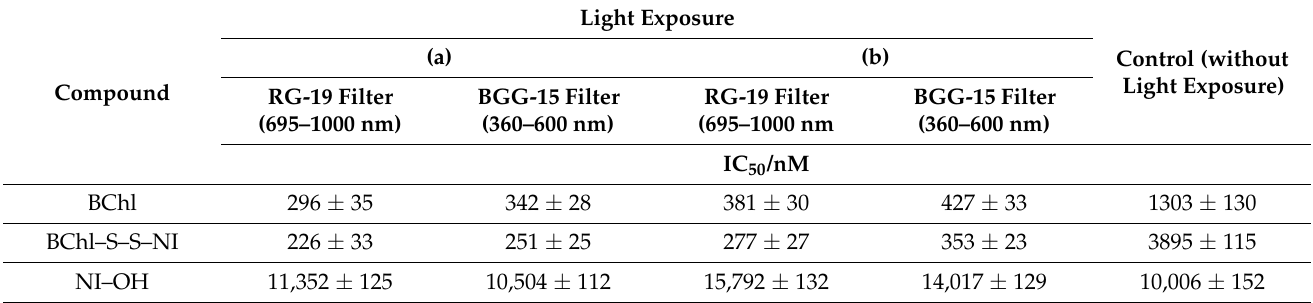
Table 2. Specific cytotoxic activity (IC 50 ) of BChl, conjugate BChl–S–S–NI, and naphthalimide dyes NI– OH: (a) irradiation without preliminary washing of the cell culture, in the presence of test compounds in the incubation medium; (b) removal of studied solution immediately before